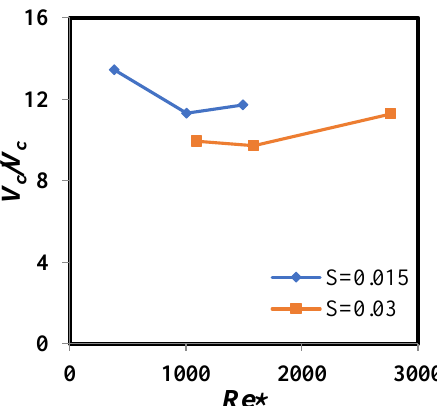
Figure 3. Relationship between V c /V c * and Re * for different bed sediments in fixed slopes of 0.015 and 0.03.